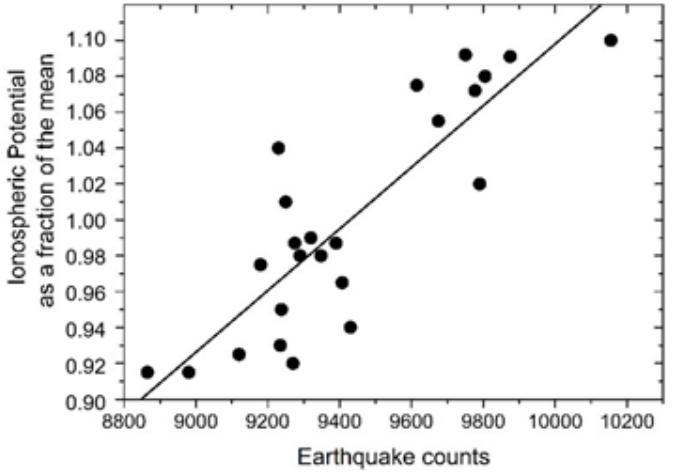
Figure 9. Distribution of the hourly values of the IP (curve B in the Figure 7) depending on the hourly values of the global number of earthquakes with a magnitude of M ≥ 4.5 at varying depths from 1973–2017, according to the NEIC global seismological catalog. The straight line is the regression between the number of earthquakes and the modeled ionospheric potential with a correlation coefficient of R = 0.855 and a standard deviation SD = 0.03 at a probability of p = 95%.